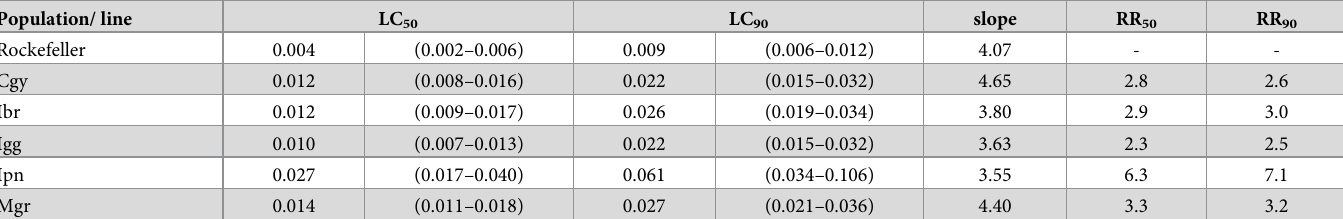
Table 3. Temephos resistance levels of Aedes aegypti populations from Rio de Janeiro. L C = lethal concentration in mg/L, values in parenthesis indicate 95% confi- dence interval (CI95%); RR = Resistance Ratio. Population/ line